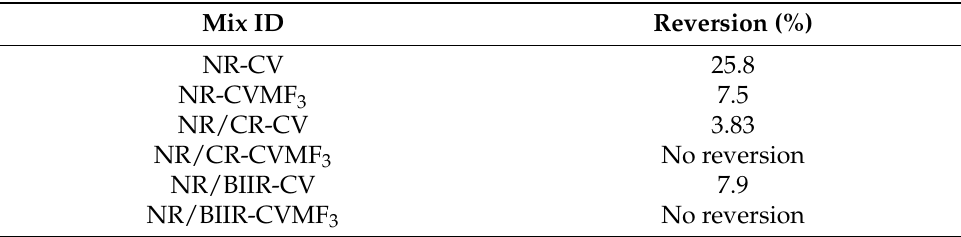
Table 3. Reversion in compounds at 170 ◦